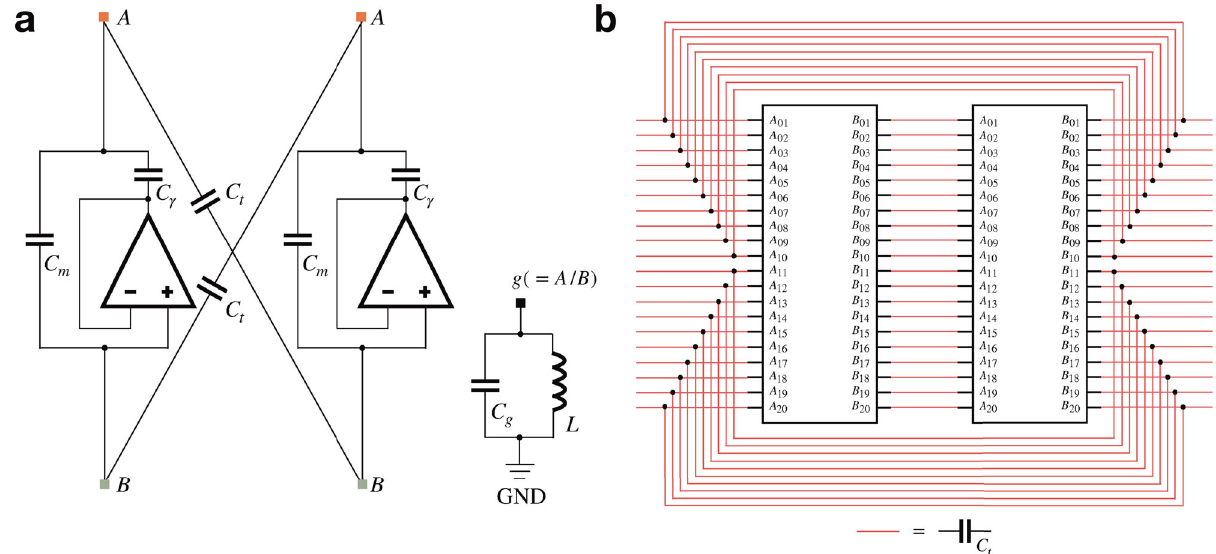
Fig. 4 Schematic illustration of the two-dimensional topolectrical circuit. a Two unit cells in the circuit lattice. The reciprocal hopping terms are realized by capacitors C m , and the non-reciprocal hopping terms are realized by the operational ampli fi ers and capacitors C γ , where current fl ow can exist between A sites and the output of the ampli fi er, but cannot exist between B sites and the input of the ampli fi er. The LC-circuits which connect the A / B sites and the ground provide the on-site frequency response. b The 40 × 40 lattice contains 80 sub-circuits, and each sub-circuit contains 20 unit cells, arranged along y direction. The schematic view shows the connection between two sub-circuits along x direction, where A n , B n denote the sites of the n th unit cell inside the sub-circuit, and the connection between the unit cells is the same as ( a ).